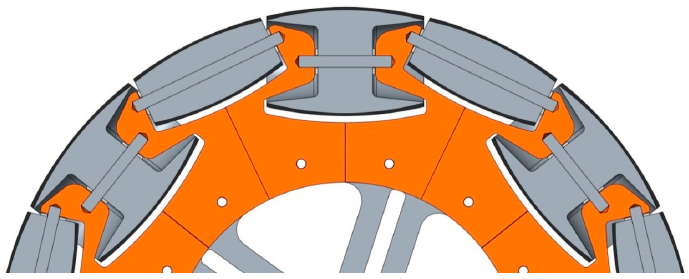
Figure 5. Design of the omnidirectional wheel: ( a ) CAD model ( b ) prototype implementation.